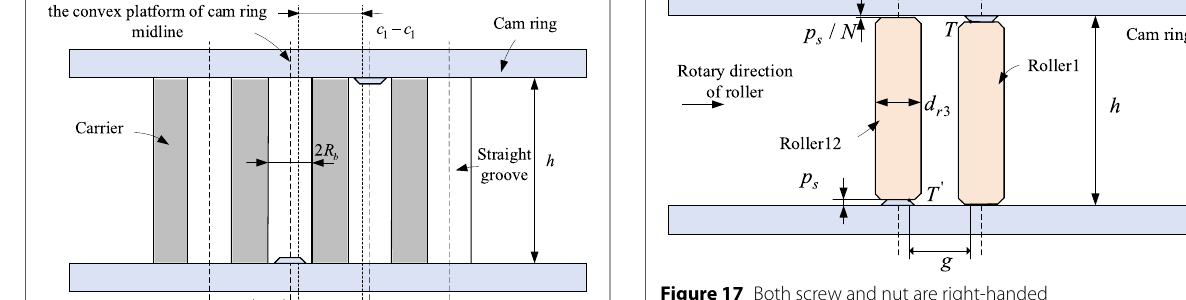
Figure 17 Both screw and nut are right-handed